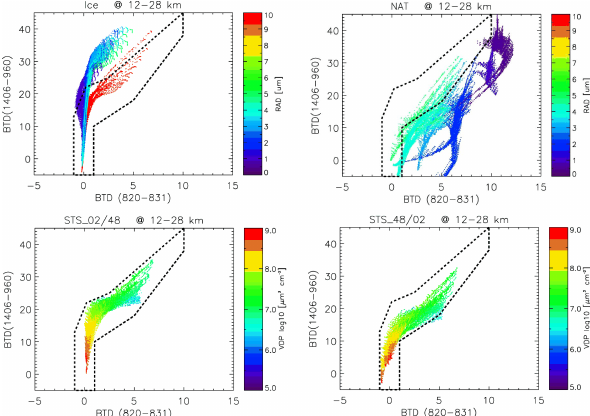
Figure 6. Scatter diagrams of BTD 820 − 831 vs. BTD 1406 − 960 dis- tribution for the CSDB spectra of Ice (top, left) and NAT (top, right) with colour-coded radius dependence and two STS compo- sitions (bottom) with colour-coded volume density path (VDP) de- pendence. The axes ranges are restricted to the BTD ranges typi- cally observed for MIPAS (see next figure). Only data with CI < 6 are presented. The superimposed polygon (dashed line) marks the area where spectra of modelled STS composition occur in the full set of the CSDB